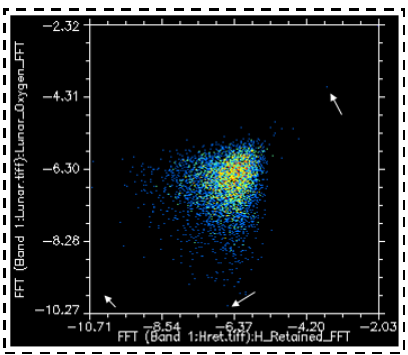
Figure 10. Scatter plot of LPT-FFT images, signifying the relationship of liberated lunar oxygen with the retained H